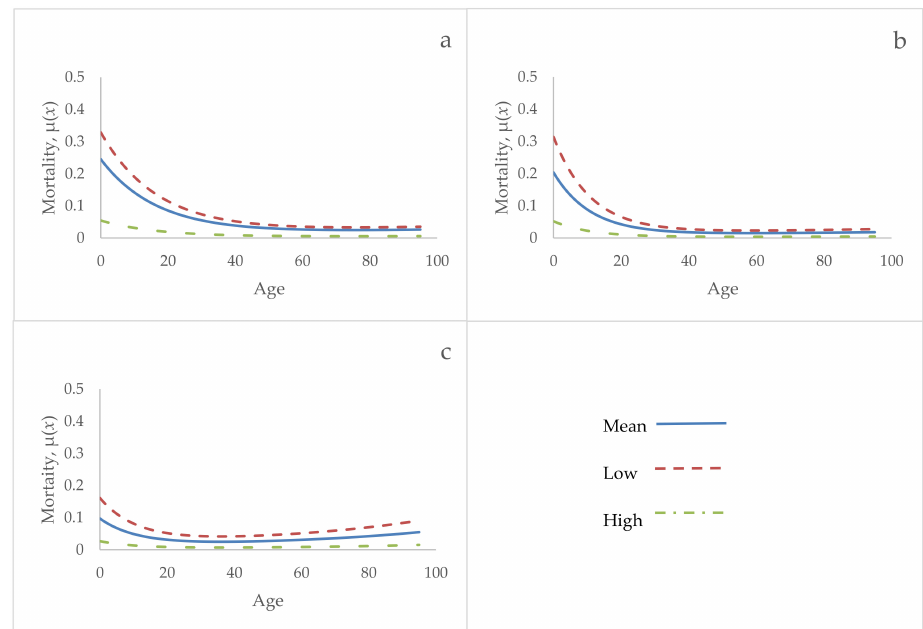
Figure 4. Age trajectories of mortality as function of di ff erent levels of shrinkage (mean, low (2.5th percentile) and high (97.5th percentile)) at site 1–3 ( a – c ) using the Gompertz bathtub model.